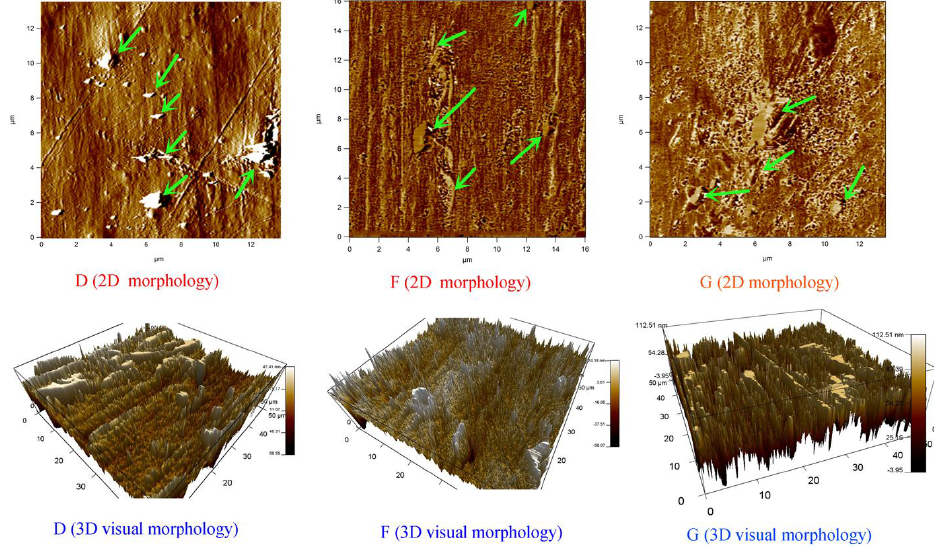
Figure 3. 2D grayscale morphologies of (D) GO 1 /PEG 3 /PLA 96 and (F) GO 1 /PEG 7 /PLA 92 based on dynamic impregnating, (G) GO 1 /PEG 7 /PLA 92 based on internal mixing and corresponding 3D visual morphologies obtained using AFM.